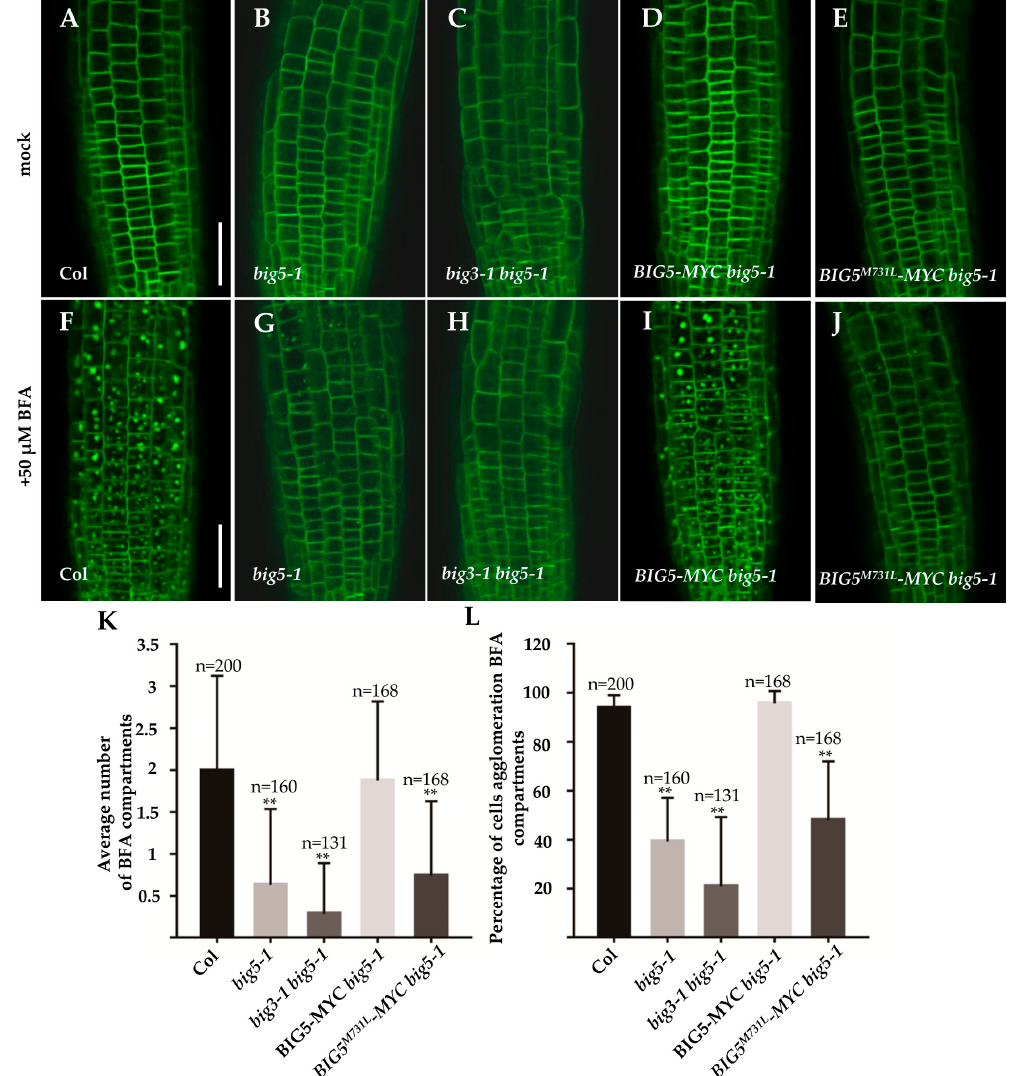
Figure 5. Aggregation of BRI1-GFP in BFA-compartments is blocked in big5 and big3 big5 mutants. ( A – E ) BRI1-GFP predominantly localize on plasma membrane. ( F ) BFA induced aggregation of BRI1-GFP in BFA-compartments. ( G , H ) No trapped BRI1-GFP signals found in both big5-1 ( G ) and big3-1 big5-1 ( H ) after BFA treatment. ( I ) BIG5-MYC restores the BRI1-GFP aggregation in BFA-compartments in big5-1 . ( J ) By contrast, BFA-resistant version BIG5 M731L -MYC complemented big5-1 growth defects but failed to induce BRI1-GFP aggregation after BFA treatment. ( K ) Number of BFA-compartments per epidermal cell. ( L ) Quantitative analysis of the percentage of cells showing BFA-compartments. Bars = 40 µ m. Error bars represent standard deviations, significant di ff erence after Student’s t -test, ** p <